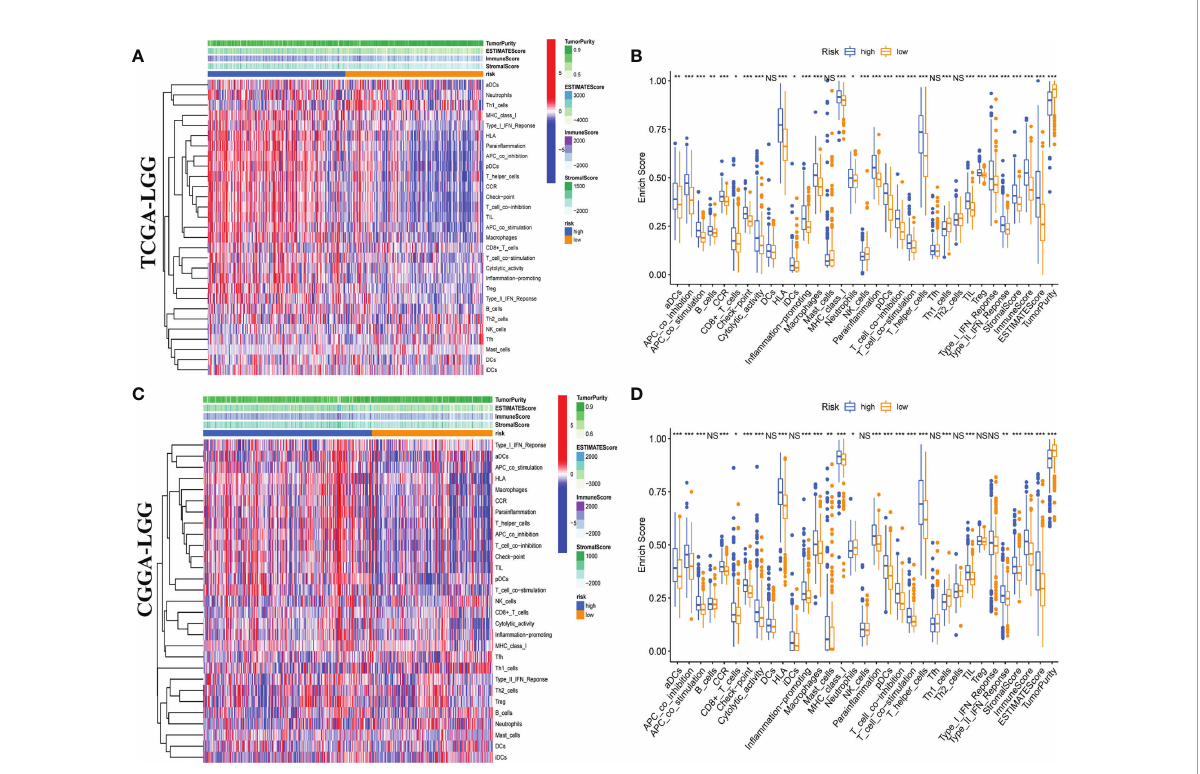
FIGURE 6 Single-sample gene set enrichment analysis (ssGSEA) of immune hallmarks. Heatmap of ssGSEA scores among low- and high-risk groups in training (A) and validation (C) sets. Boxplot of ssGSEA scores, stromal score, immune score, and tumor purity among low- and high-risk groups in TCGA (B) and CGGA (D) cohorts. NS, Non Signi fi cance, ***p < 0.001, **p < 0.01, *p <